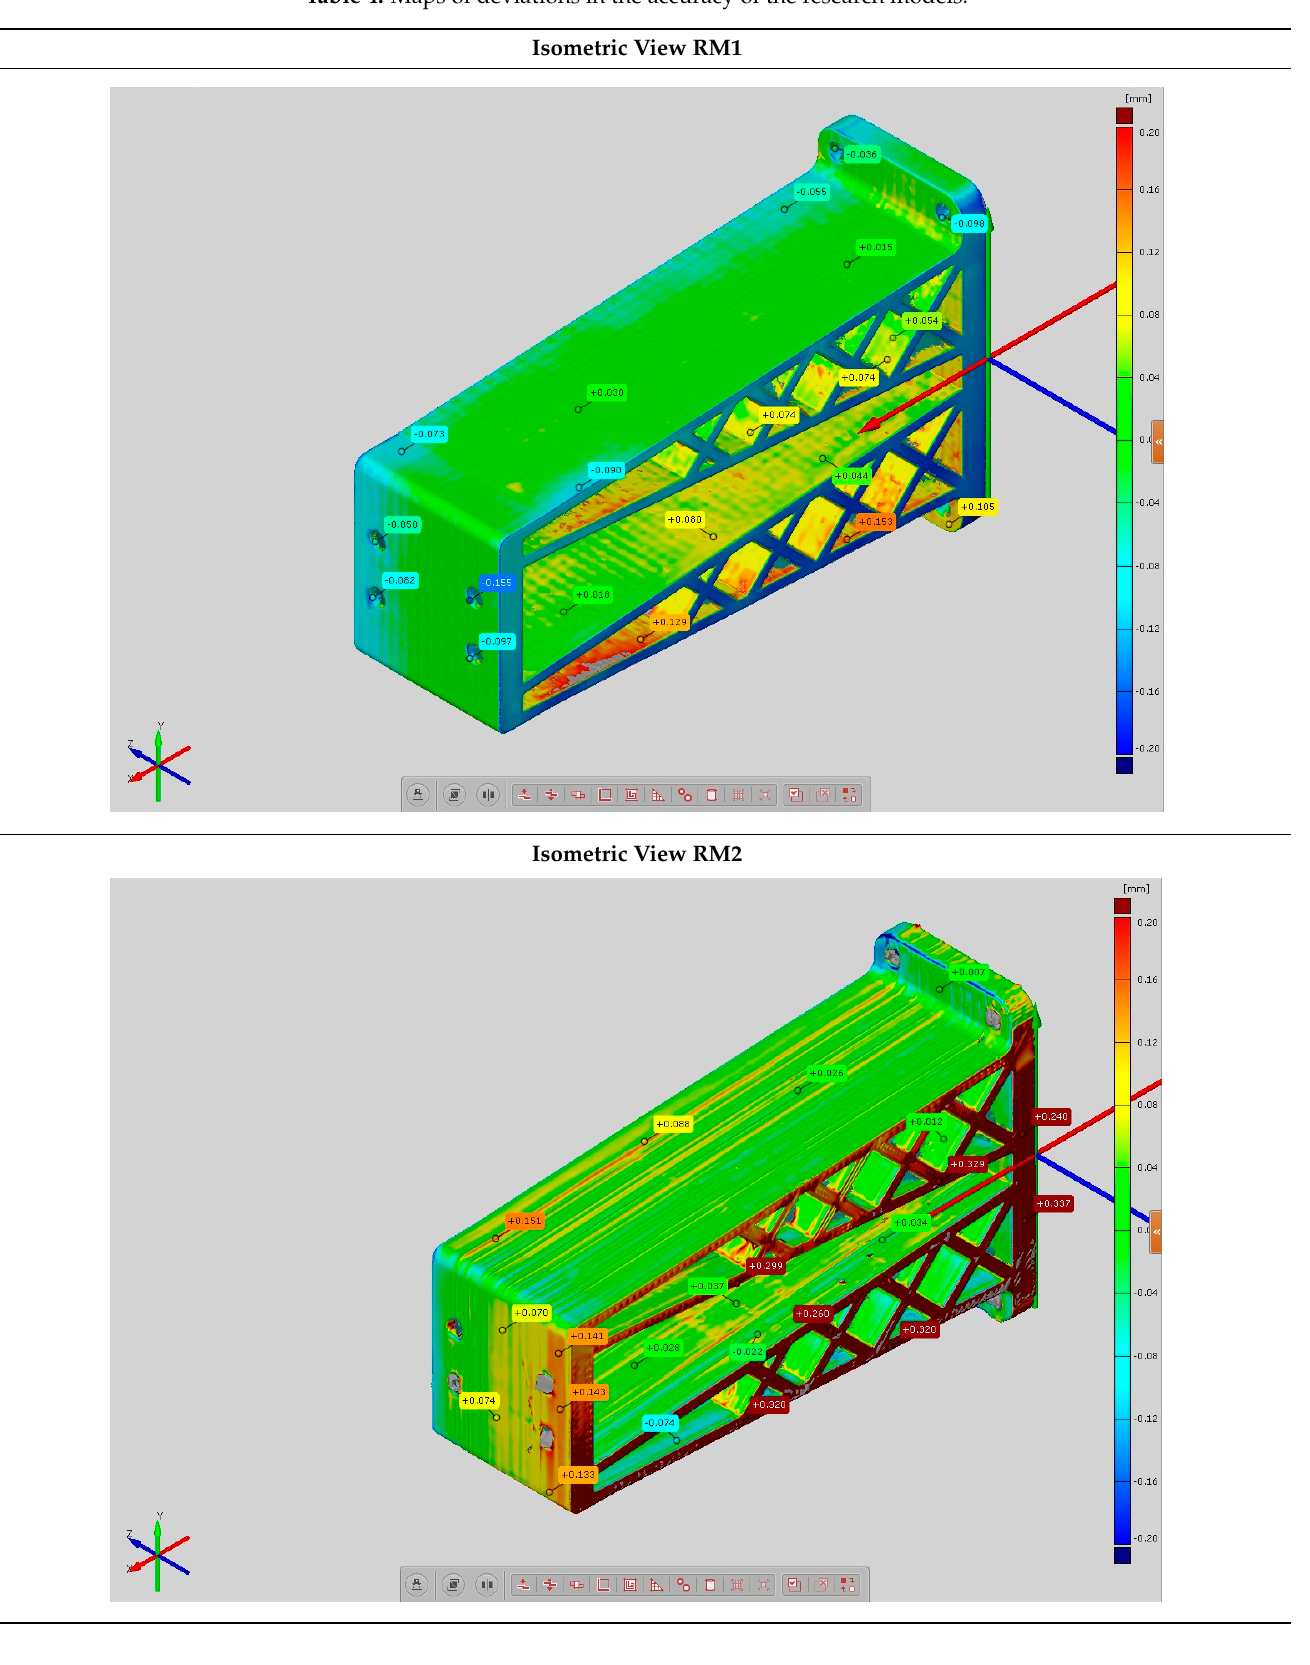
Table 4. Maps of deviations in the accuracy of the research models.